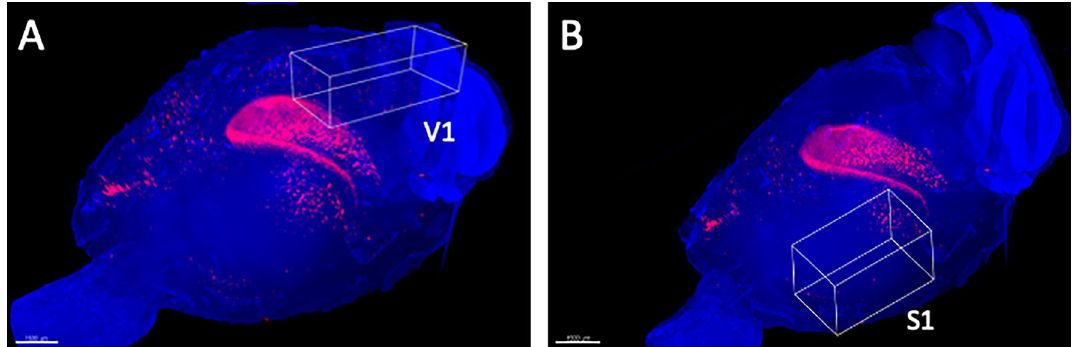
Figure 3. 3D ROI settings in V1 and S1. ( A ) 3D ROI setting in the primary visual cortex (V1). ( B ) 3D-ROI setting in the primary somatosensory cortex (S1). Only the left hemisphere is shown, since showing both hemispheres would interfere with clarity due to image overlapping.